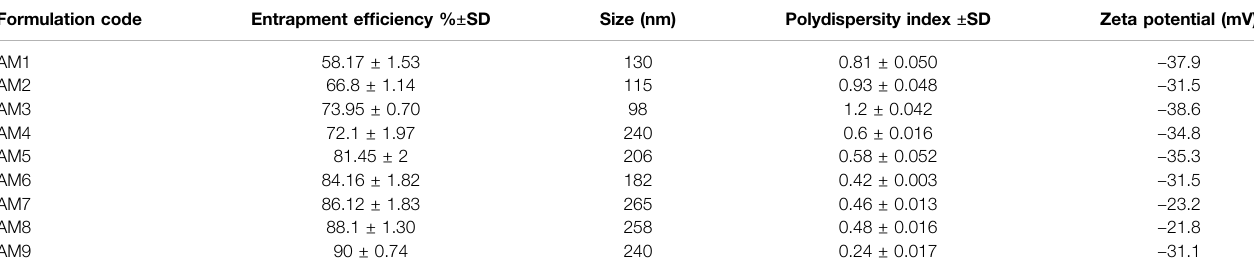
TABLE 4 | Effects of variable on responses. Formulation code